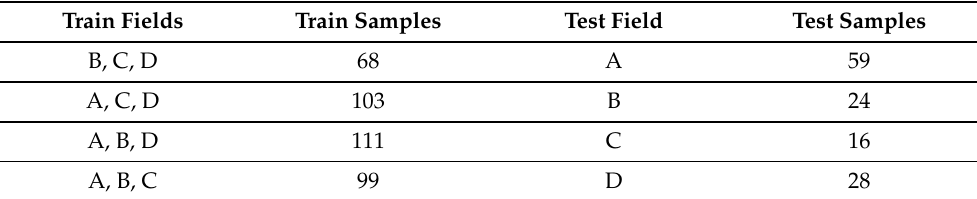
Table 5. Parametric and non-parametric training and test split ratios.